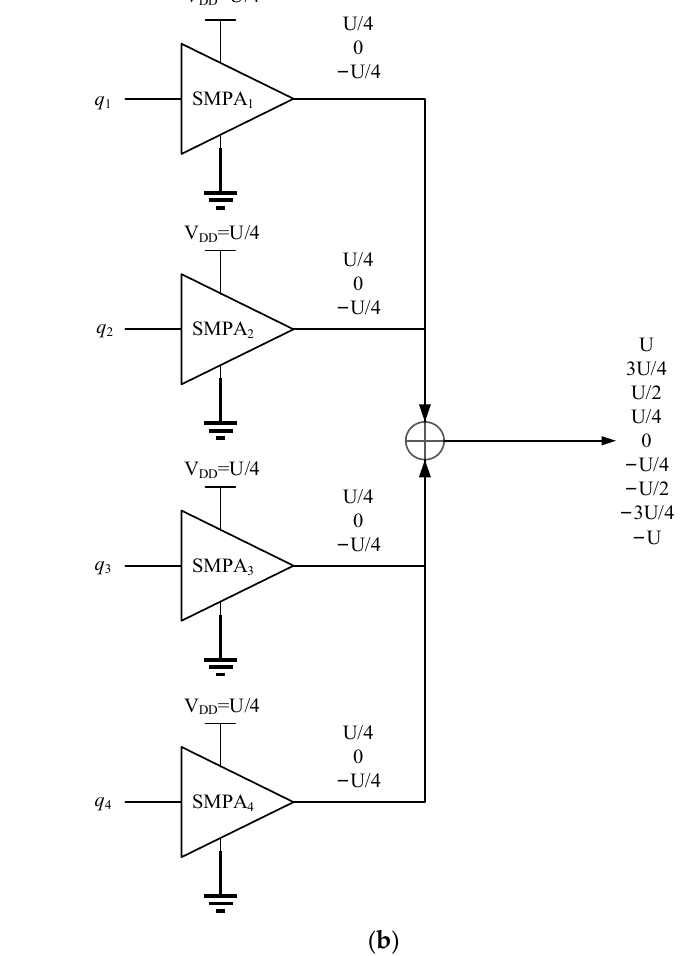
Figure 5. The circuit topological structure of SMPA when the output pulse is ( a ) five-level RF-PWM signal ( b ) nine-level RF-PWM signal, under the same maximum of output voltage.